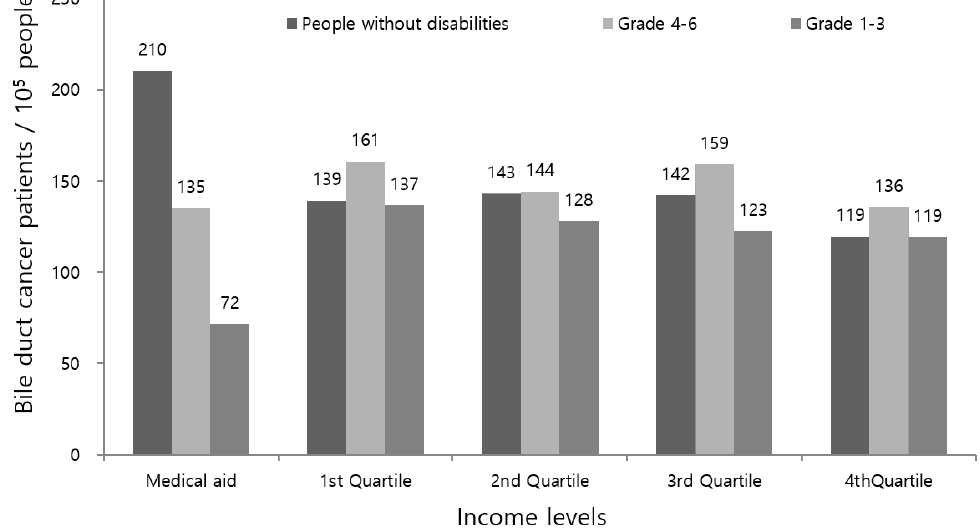
Figure 2. Comparison of income level structure in patients with BDC between those with or without disabilities (household income level was categorized as: below the poverty line (medical aid, lowest income level) and quartiles I, II, III, and IV (highest); disability severity was also classified as severe (grades 1 – 3) or mild (grades 4 – 6)) .